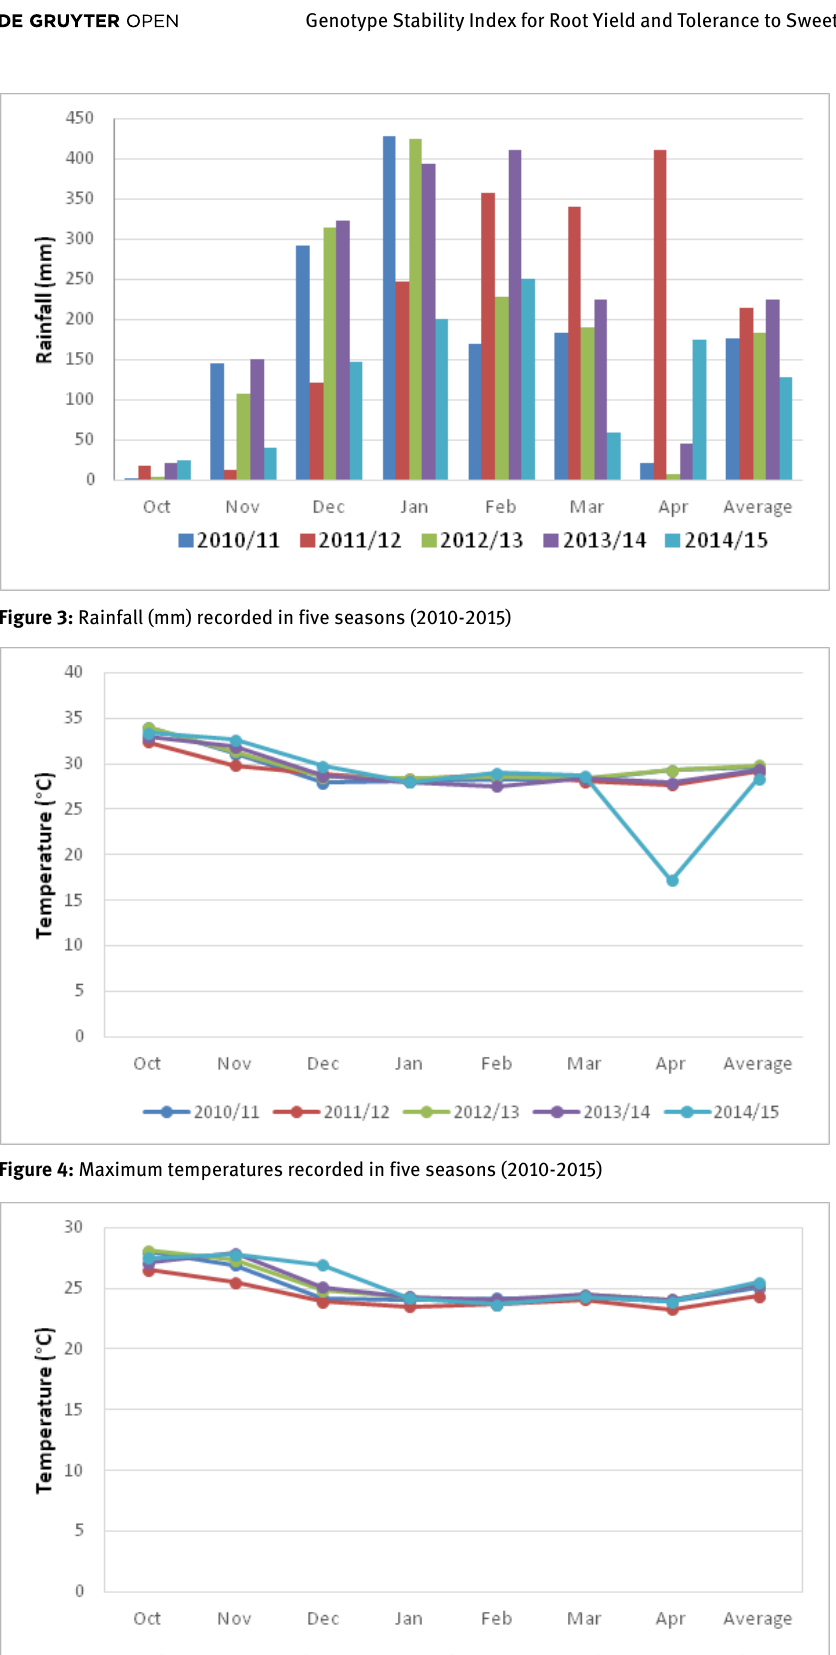
Figure 5: Soil temperatures recorded at 30 cm depth over five seasons